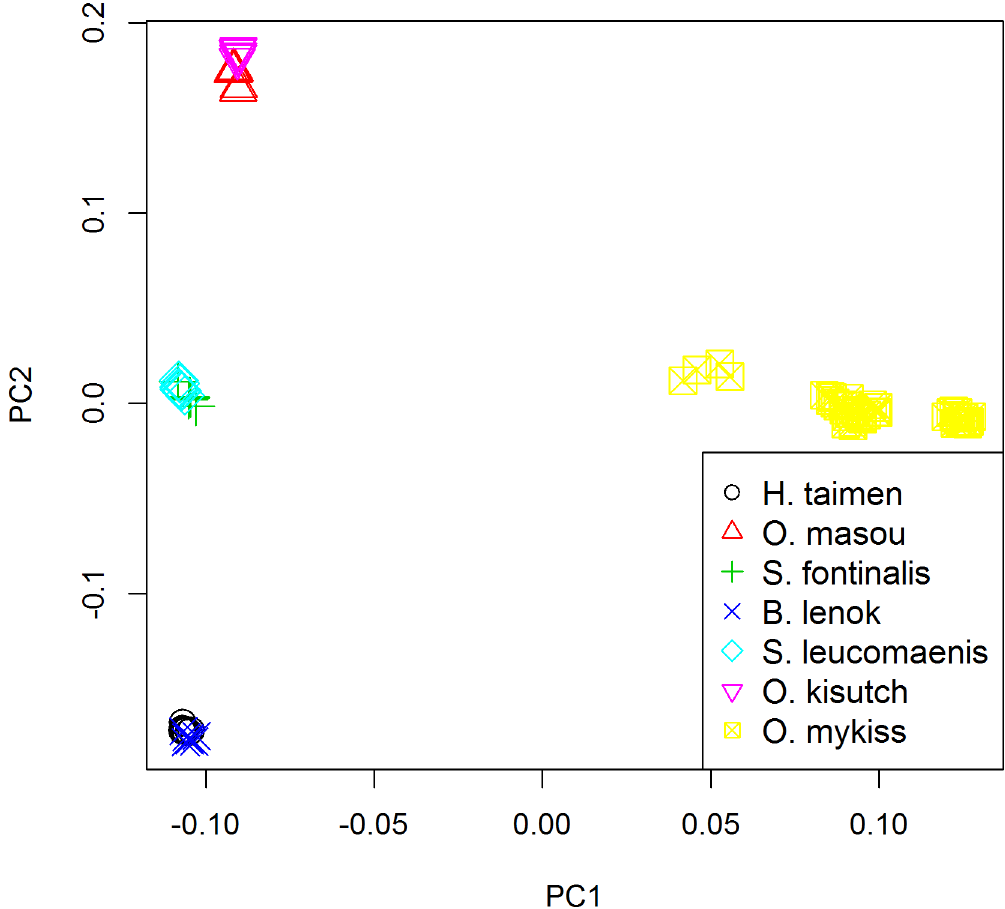
Fig 2. PCA of 96 individuals from seven salmonid populations (PC1: 33.4% of variance against PC2: 8.2% of variance) based on 28,882 shared SNP markers using the GCTA software. Each individual is represented by one point. Each population is shown by different